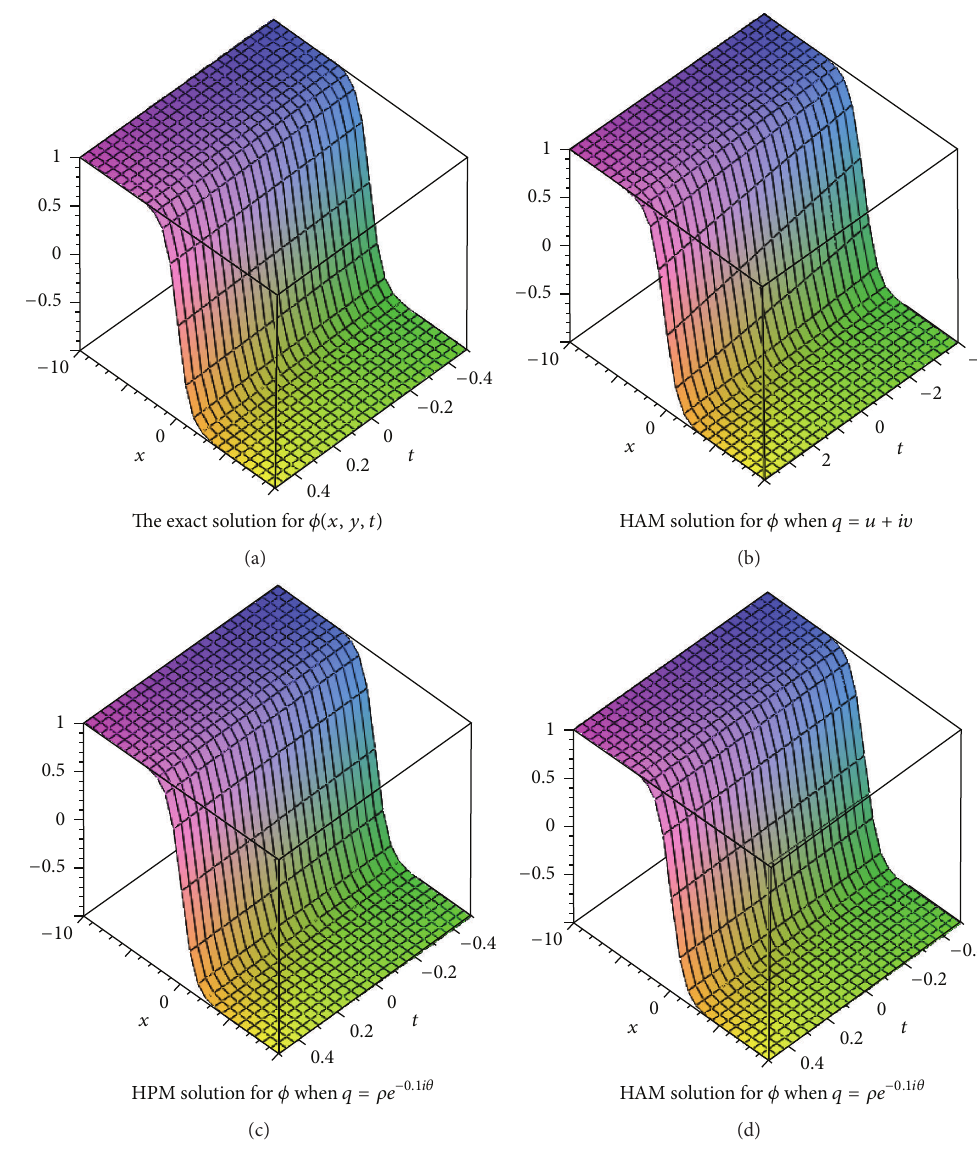
Figure 2: Comparison between the exact solution, the HPM solution, and the HAM solution for 𝜙(𝑥,𝑦,𝑡) .